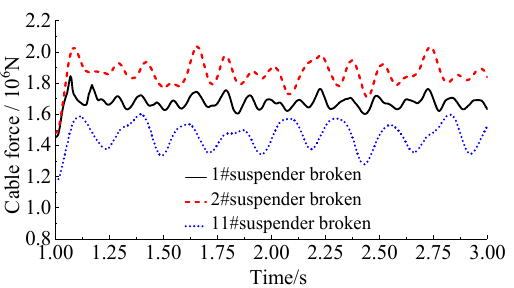
Figure 24. Suspender force time history curve of the suspender adjacent to the ruptured hanger.